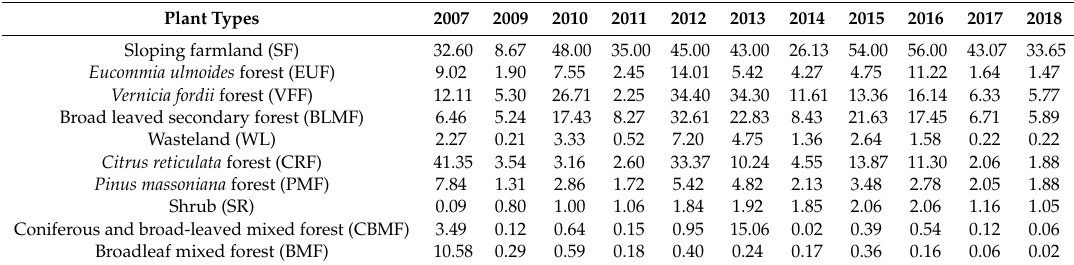
Table 4. Annual sediment yield from each vegetation type between 2007 and 2018 (t / hm 2 ). Plant Types